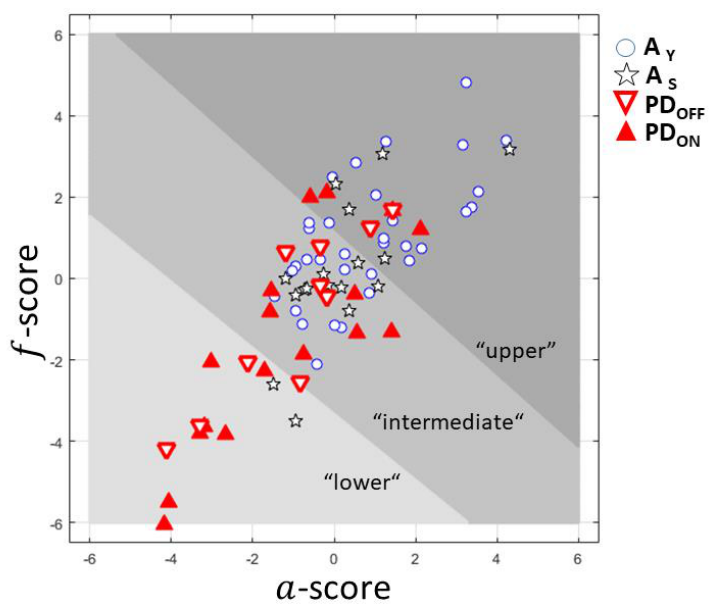
Figure 2. The a -score vs. f -score plane for asymptomatic subjects (A Y and A S ) and PD subjects (PD off and PD on ).